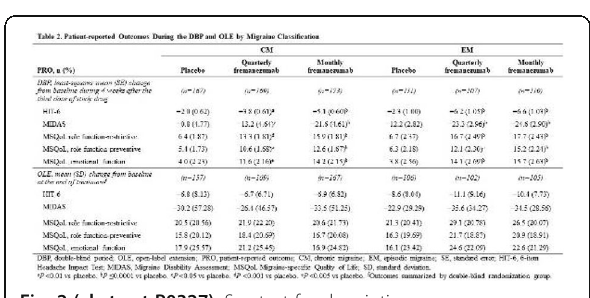
Fig. 2 (abstract P0327). See text for